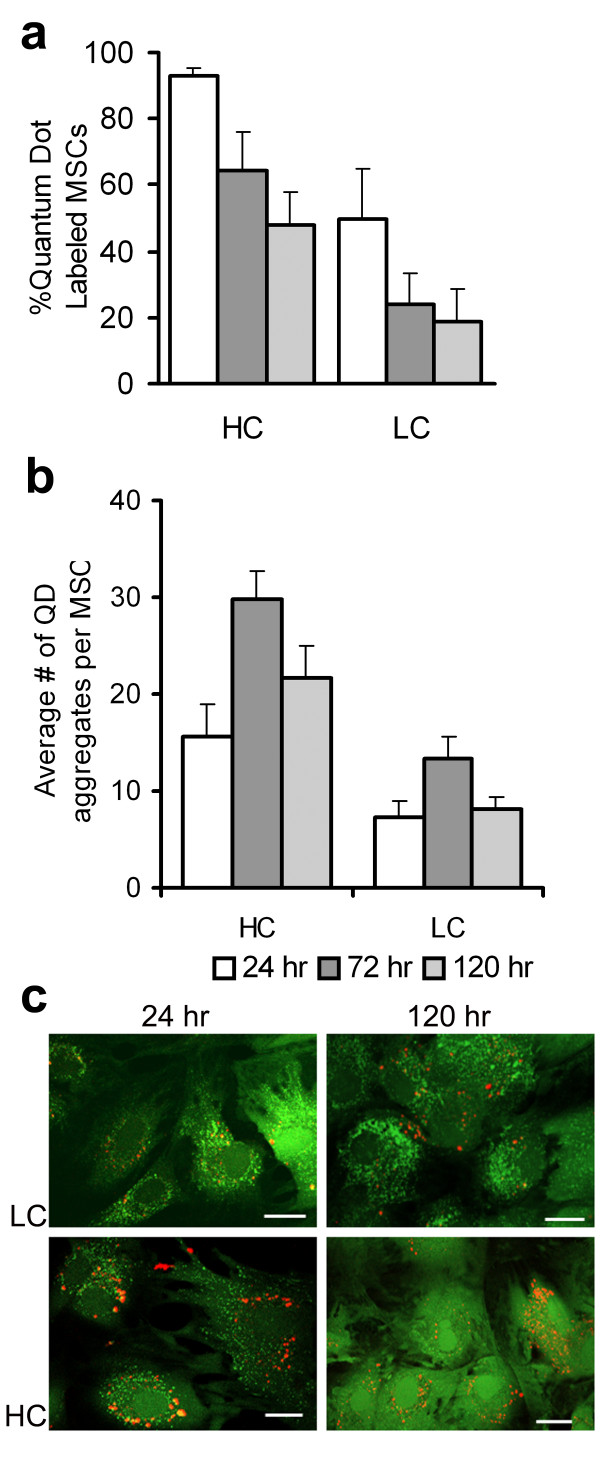
Intracellular QD yield, retention and distribution in expanding MSC cultures. a. Flow cytometry results of QD positive MSCs in HC and LC groups at 24, 72 and 120 hrs post labeling. A dose-dependent effect is shown with increased HC vs. LC QD labeled MSCs detected at each time point (p < 0.05). b. Quantitative imaging results show a greater number of QD aggregates in the HC vs. LC MSCs at each time point (p < 0.05). The average number of intracellular QD aggregates increased from 24 to 72 hrs in both groups of MSCs (p < 0.05). No statistically significant changes in QD aggregates were measured from 72 – 120 hr. c. Representative confocal fluorescent images of LC and HC MSCs co-labeled with calcein (green) at 24 and 120 hrs. Each image represents a 1 μm thick optical slice establishing a peri-nuclear intracellular distribution of QDs. As the MSCs proliferated QDs remained bright and easy to detect. Scale bar 20 μm.